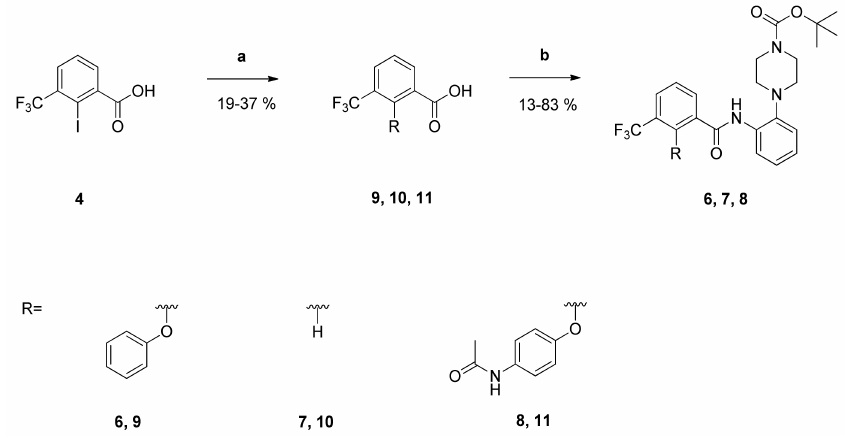
Figure 2. Preparation of compounds 6 , 7 and 8 . Reagents and conditions: ( a ) corresp. phenol, 1,8-diazabicyclo[5.4.0]undec-7-ene, Cu, CuI, pyridine, DMF, 160 ◦ C, 2–48 h; ( b ) (1) anilino derivative 3 , CH 2 Cl 2 , 0 ◦ C, 5 min; (2) 2-chloro- N -methylpyridinium iodide, DIPEA, rt, 24–48 h.